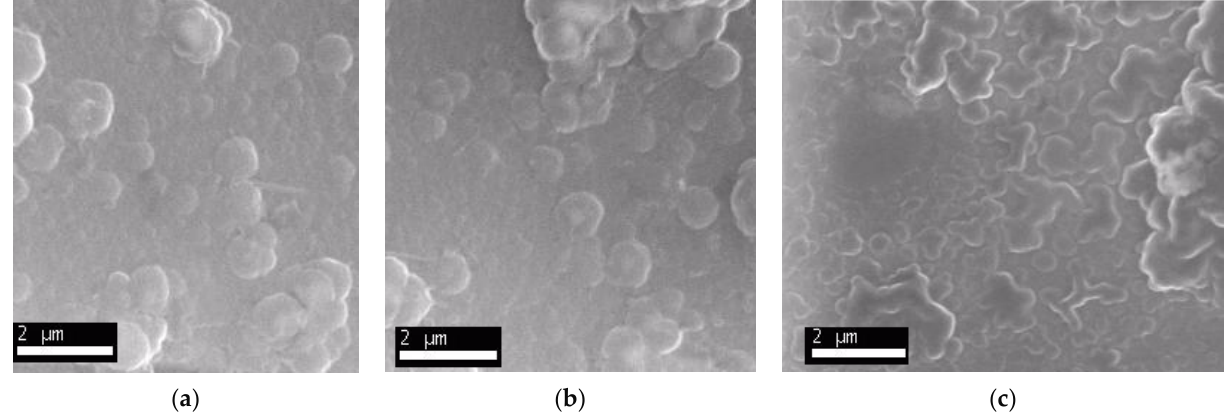
Figure 5. Scanning electron microscopy images of the sensitive element of polypyrrole based sensors doped with ( a ) FeCN, ( b ) NP, and ( c ) SDS.